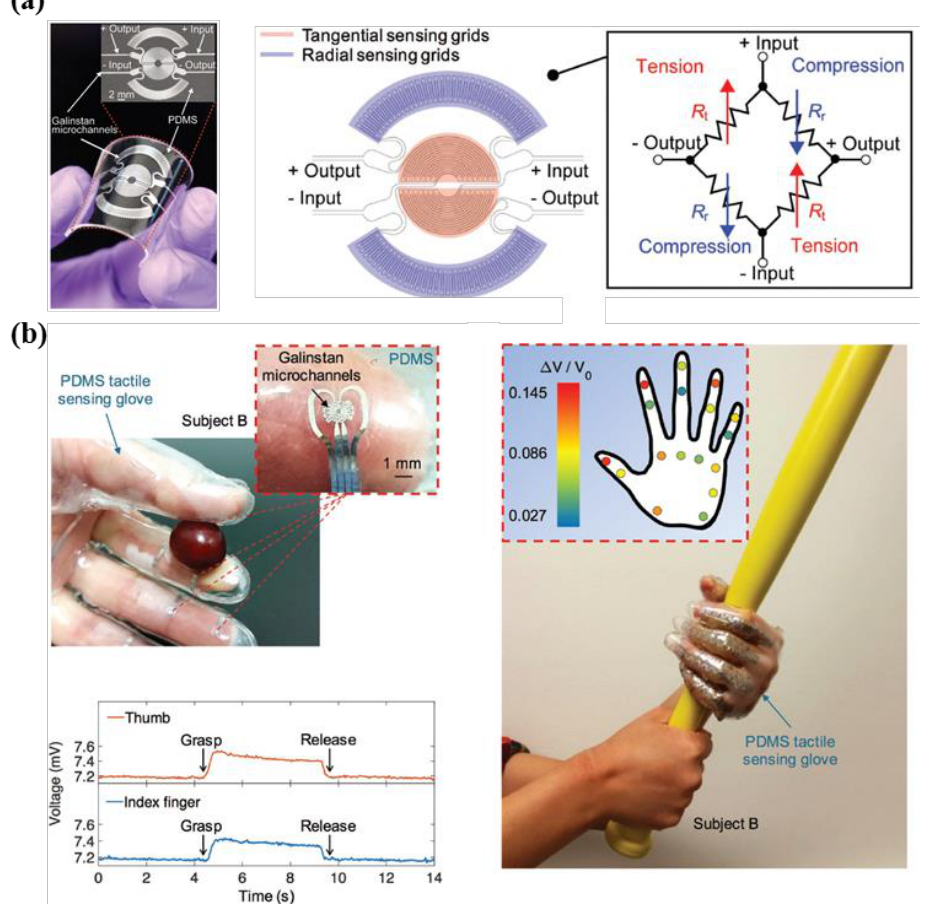
Figure 16. ( a ) Photograph of the microfluidic diaphragm pressure sensor (left). Illustration showing a layout of the sensing area including tangential and radial sensing components (middle). Circuit diagram of the device using a Wheatstone bridge (right); ( b ) Photographic image indicating the tactile sensing glove equipped with the device (top left). Plot showing real-time measurement during the motion of gripping a grape, by using thumb and index finger (bottom left). Photographic image showing the array sensing capabilities, when grasping a bat (right) (reprinted with permission for Figure 16a,b from Ref. [146] Copyright 2017 John Wiley and Sons).